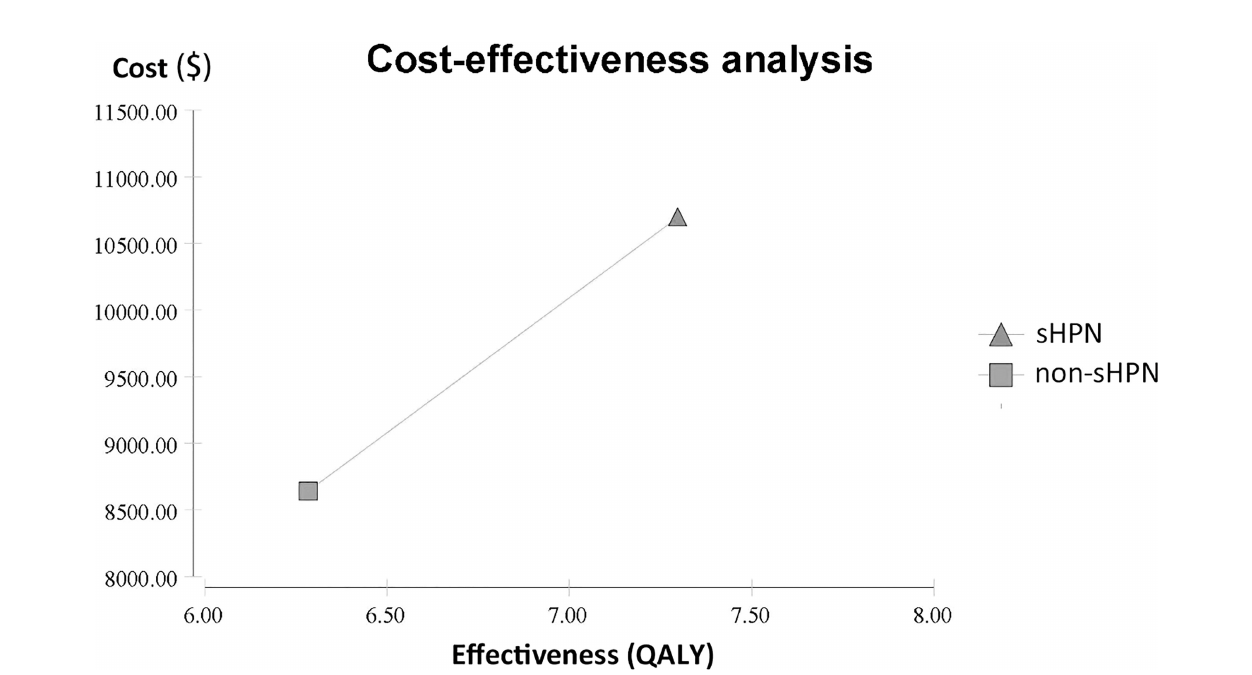
FIGURE 1 | Cost-effectiveness analysis between the sHPN group and the non-sHPN group. QALY, quality-adjusted life year; sHPN, supplemental home parenteral